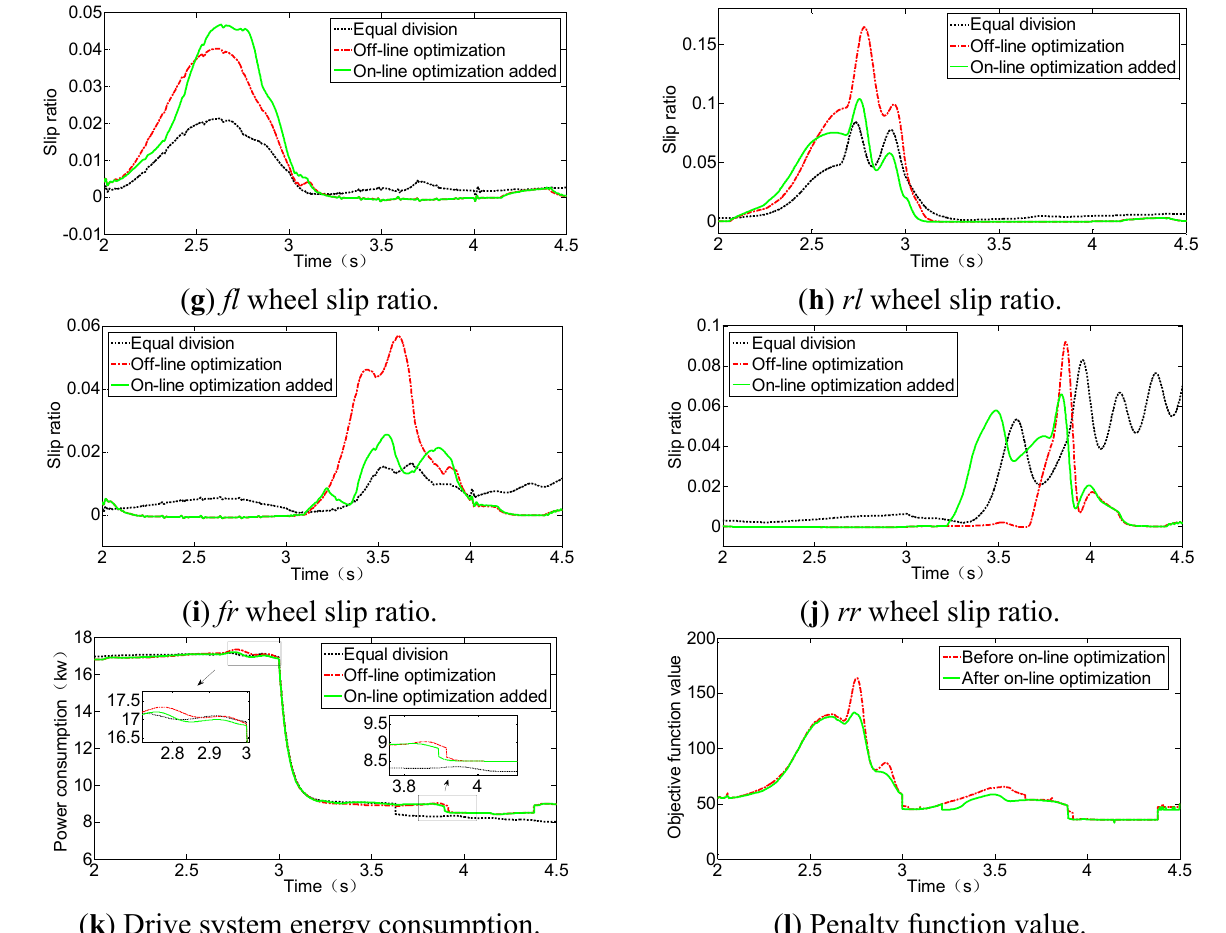
Figure 9. The vehicle state under small